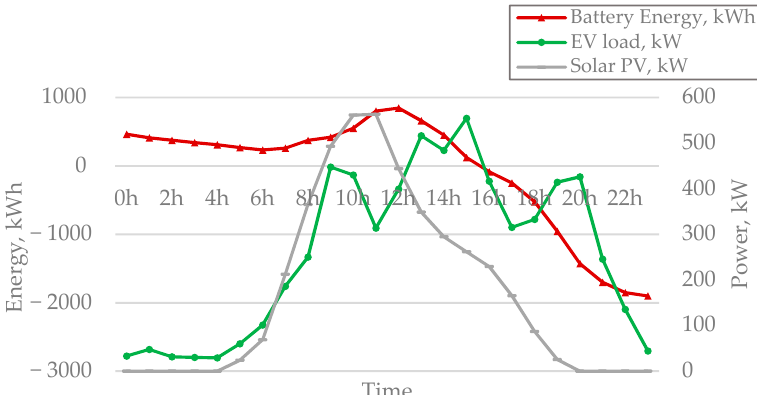
Figure 3. Charging and discharging powers of battery.